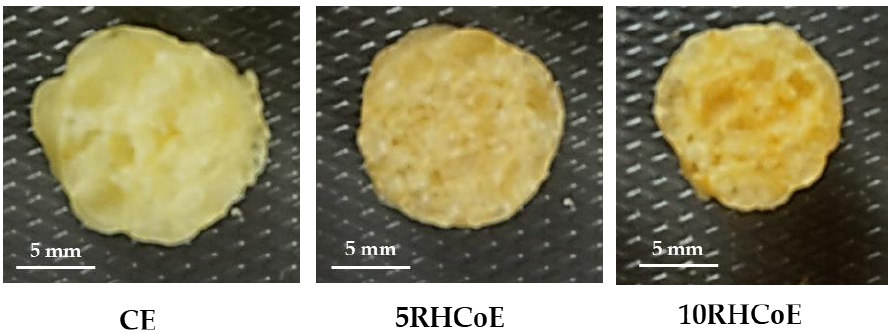
Figure 4. Radial cross-sections of extruded samples obtained from image analysis. Pearson correlation coefficients among studied parameters and RHCo